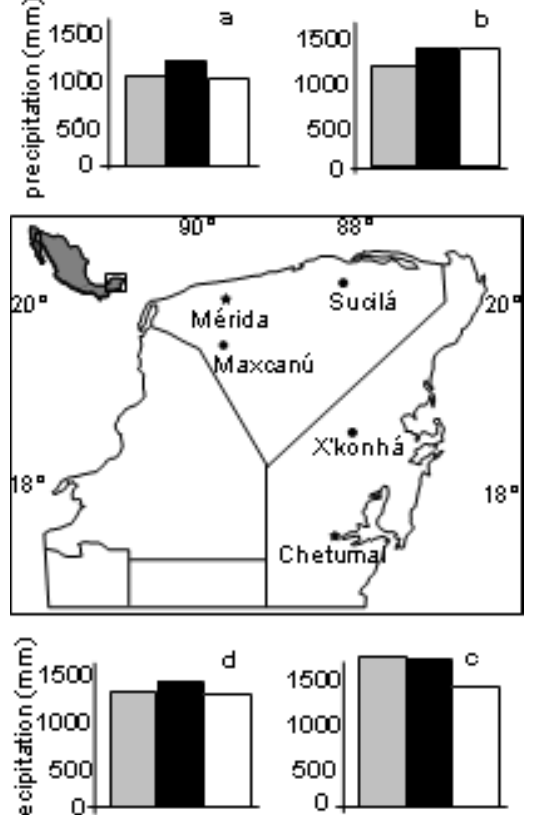
Fig. 1. Location of the study sites and annual precipitation for 1998 (gray bars), 1999 (black bars), and 2000 (white bars) in a) Maxcanú, b) Sucilá, c) X’Konhá, and d) average for the three